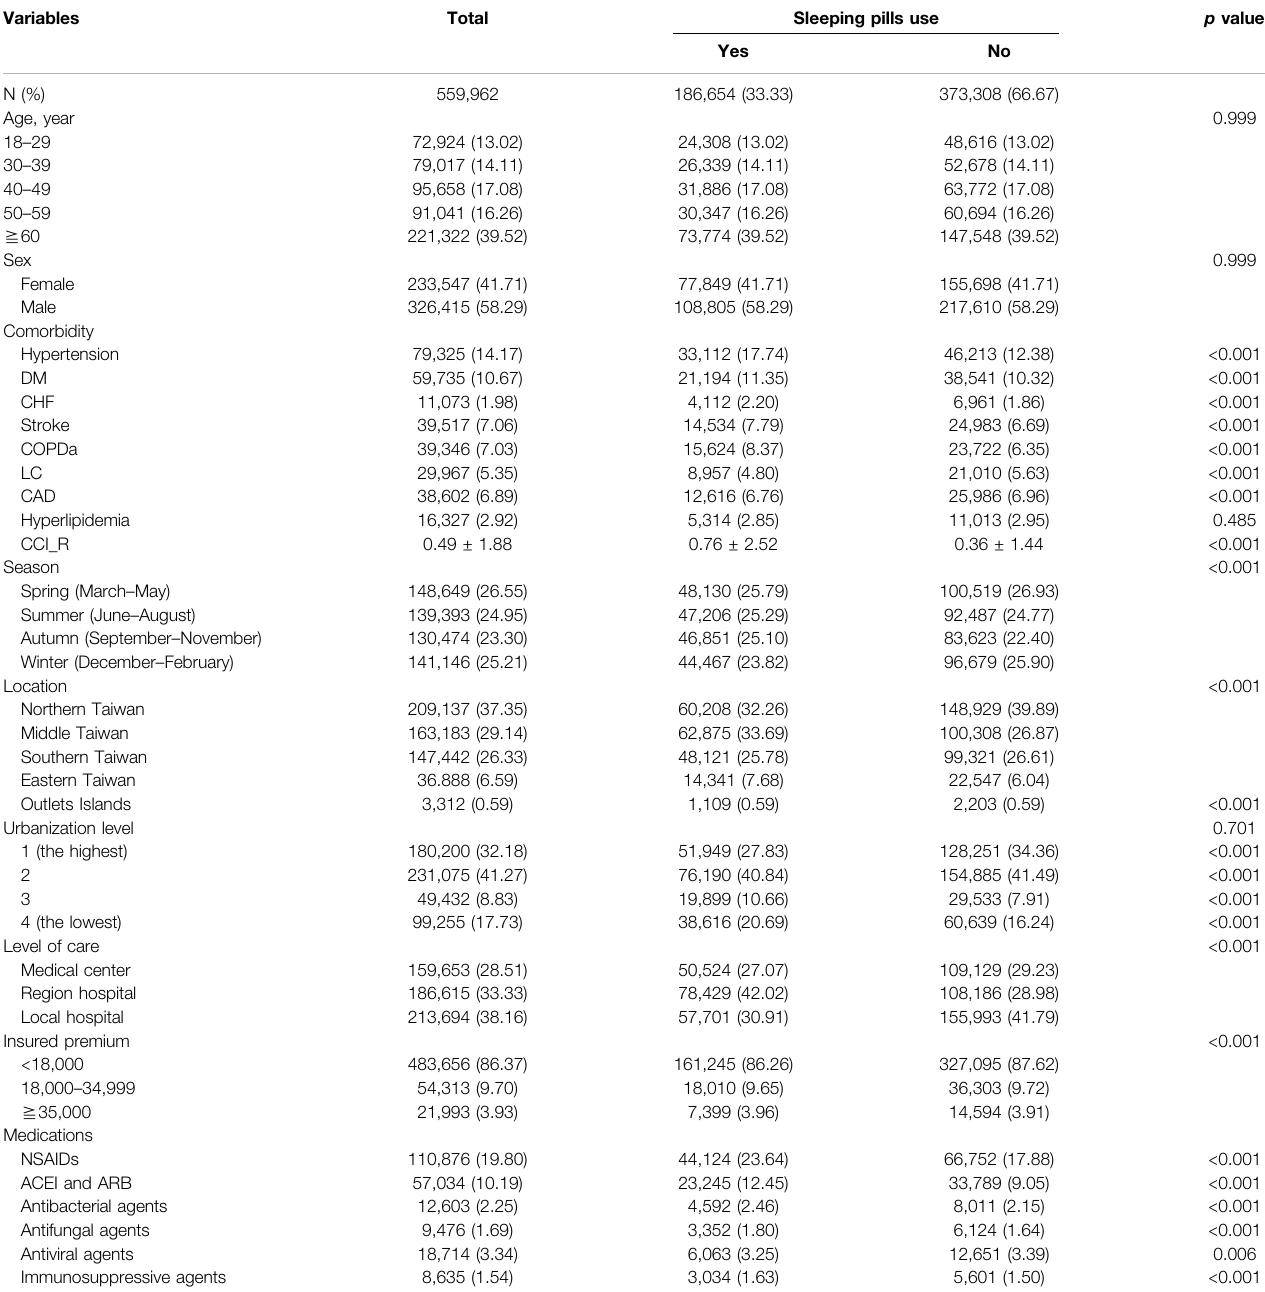
TABLE 2 | Demographic characteristics and comorbidities in cohorts with and without sleeping pills use. Variables Total Sleeping pills